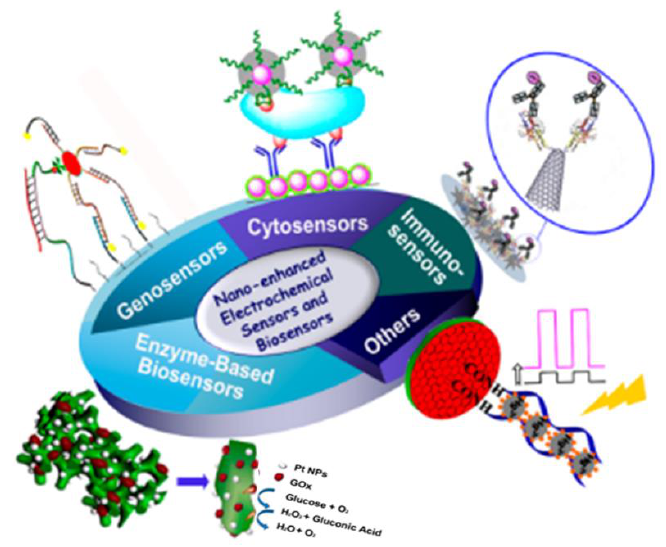
Figure 27. Schematic of electrochemical sensors and biosensors related to nanomaterials and nanostructures, in which electrochemical sensors for small molecular, enzyme-based biosensors, genosensors, immunosensors, and cytosensors are demonstrated. Reprinted with permission from Zhu, C.; Yang, G.; Li, H.; Du, D.; Lin, Y. Electrochemical sensors and biosensors based on